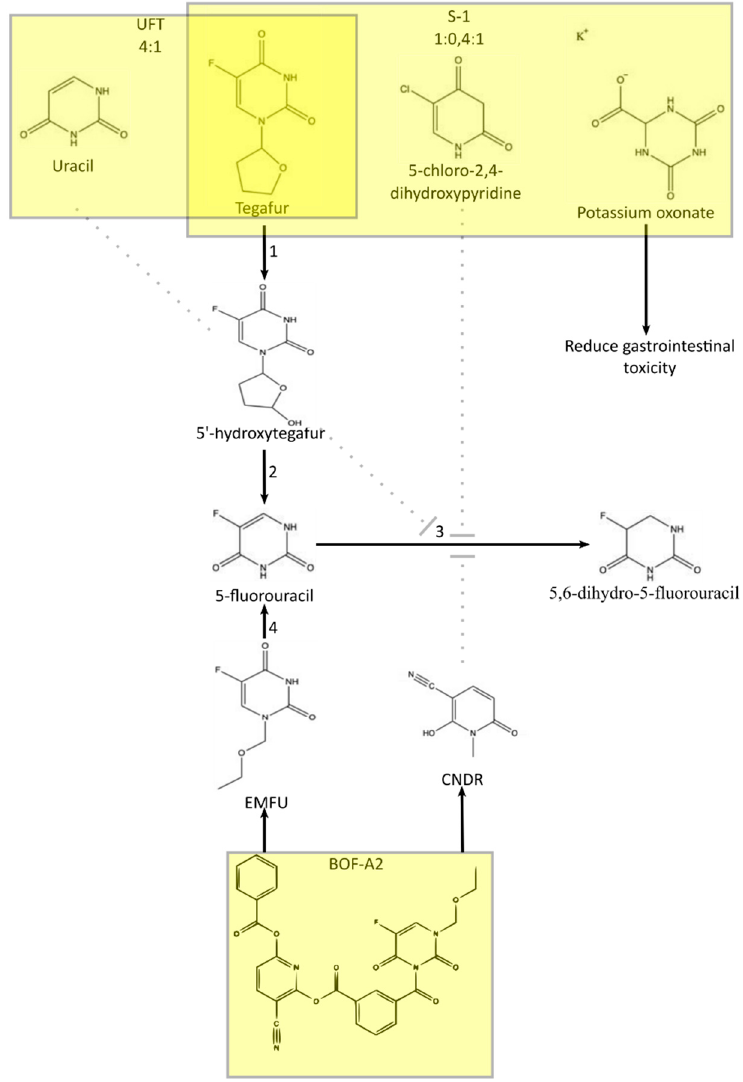
Figure 3. Metabolism of the prodrugs of 5-fluorouracil: UFT, S-1, and BOF-2A. 1—cytochrome P450 enzymes, 2—spontaneous degradation, 3—DPD, dihydropyrimidine dehydrogenase, and 4—hepatic microsomal enzymes. EMFU—2,6-dihydroxy-3-cyanopyridine; CNDP-3-cyano-2,6-dihydroxypyridine. Based on: Mallet–Martino et al., Miura et al., and Shirasaka et al. with modification.